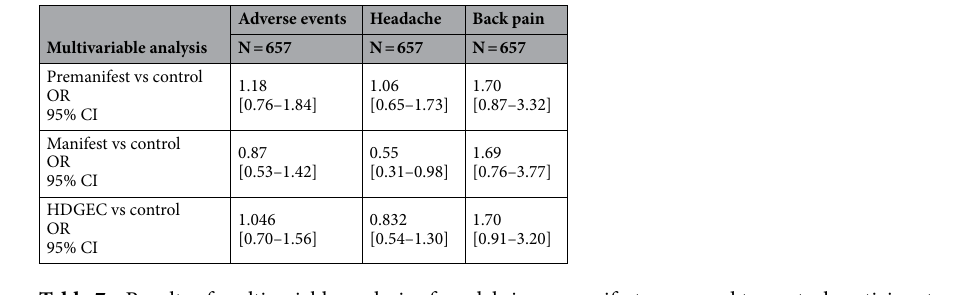
Table 7. Results of multivariable analysis of models in premanifest compared to control participants and in manifest compared to control participants. HDGEC HD gene expansion carrier, OR Odd ratio.